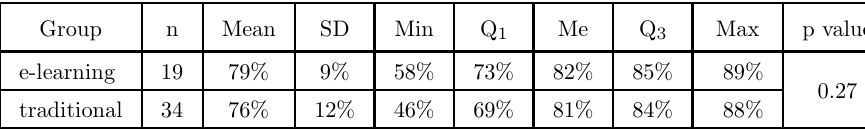
Table 5. Final results (%) of the subject “Ophthalmology and ophthalmological nursing” Group n Mean